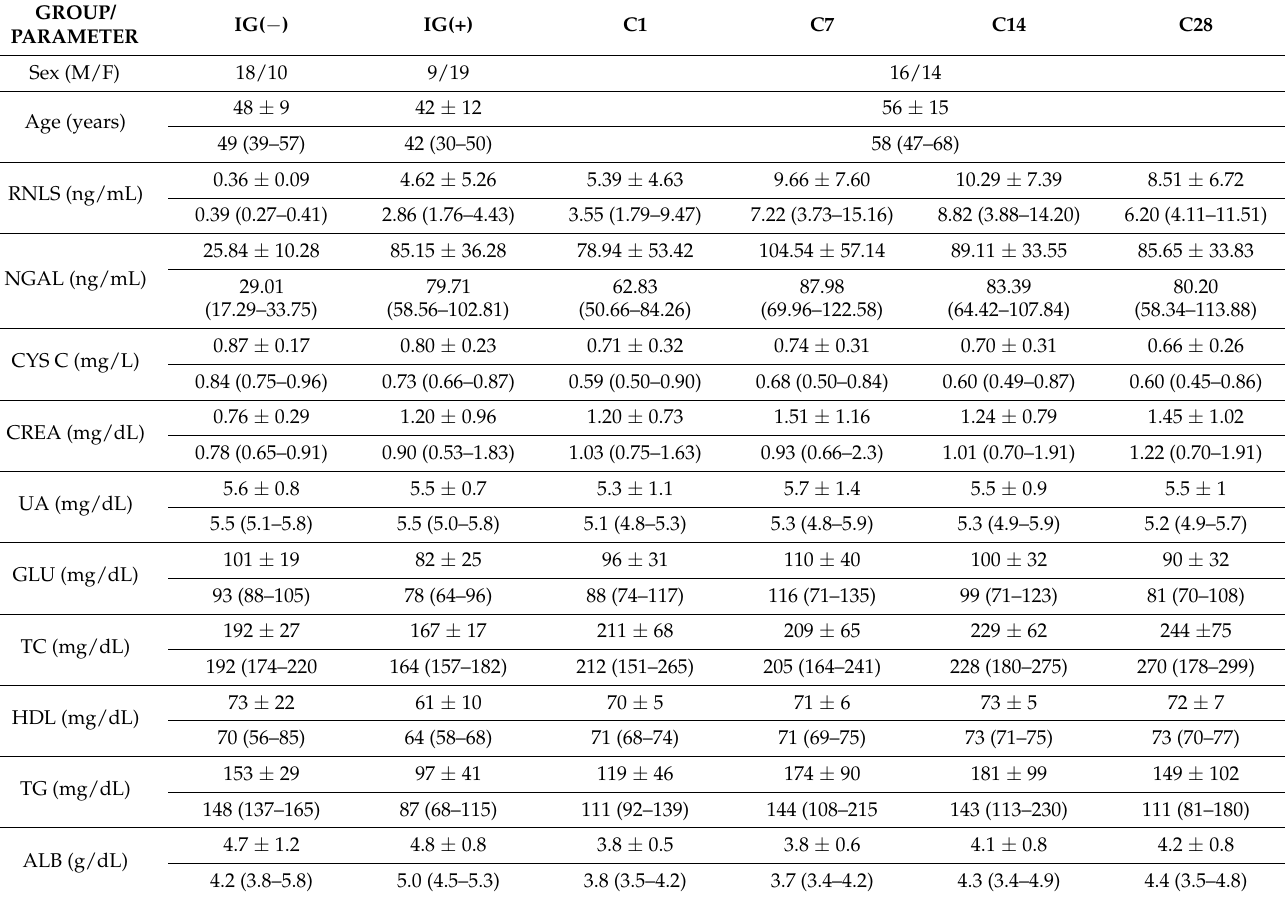
Table 1. Results of ELISA and biochemical measurements; data are shown as mean ± standard devia- tion and median (lower quartile–upper quartile); RNLS—renalase; NGAL—neutrophil gelatinase- associated lipocalin; CYS C—cystatin C; CREA—creatinine; UA—uric acid; GLU—glucose; TC—total cholesterol; HDL—high-density lipoprotein; TG—triglycerides;